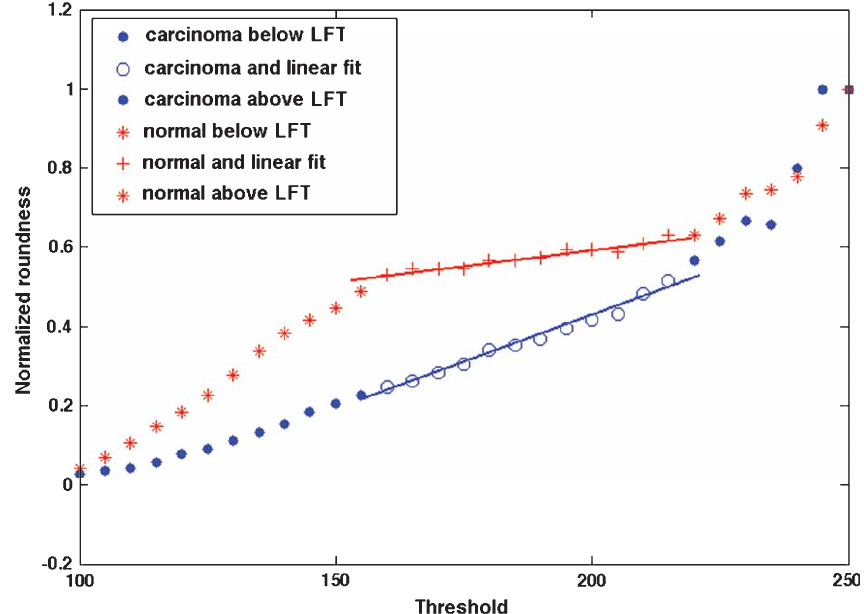
Fig. 4. Relative roundness in dependence of the intensity threshold for carcinoma and normal tissue of patient 1. The linear fits shown have been calculated for the values between threshold (LFT) 170 and 230. The mean roundness values based on this linear fit for carcinoma and normal tissue are significantly